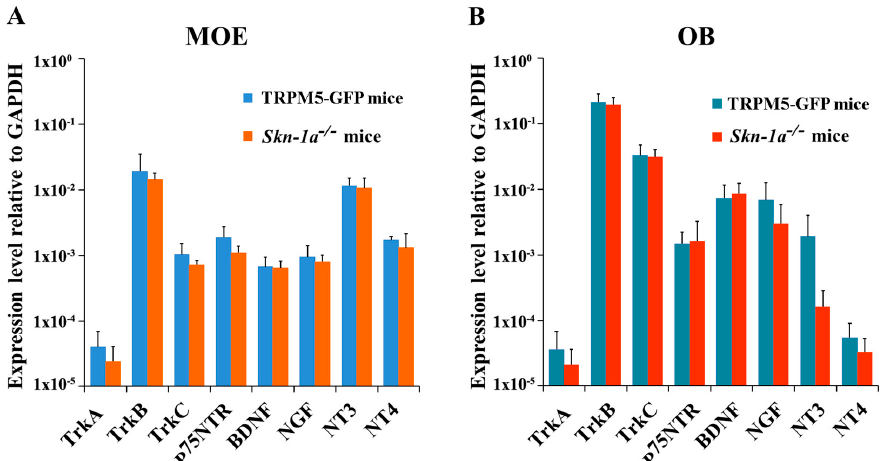
Figure 2. Expression levels of neurotrophin and neurotrophin gene transcripts in the MOE and OB of vehicle-exposed TRPM5-GFP and Skn-1a − / − mice. Real-time qPCR was performed using total RNA extracted from ( A ) olfactory turbinate tissue consisting primarily of the MOE, and ( B ) the OB. The expression levels are plotted relative to the expression of the Gapdh reference gene. ( A ) Expression levels of each NT and NTR in the MOE of TRPM5-GFP and Skn-1a − / − mice. Similar expression patterns across the NTs and NTRs were found in both TRPM5-GFP and Skn-1a − / − mice with NT-3 and TrkB expression levels being the highest among NTs and NTRs, respectively. No statistically significant differences were detected in the expression of each gene in the MOE between TRPM5-GFP and Skn-1a − / − mice (two-tailed independent t -test, p > 0.05, n = 6 mice). ( B ) Expression levels of NTs and NTRs in the OB of TRPM5-GFP and Skn-1a − / − mice. Among the NTRs examined, TrkB showed the highest expression in both TRPM5-GFP and Skn-1a − / − mice (one-way ANOVA with Tukey’s post-hoc test, p < 0.05, n = 6). No statistically significant differences were detected in the expression of each gene in the OB between TRPM5-GFP and Skn-1a − / − mice (two-tailed independent t -test, p > 0.05, n = 6 mice). Bar graphs represent the mean ± standard deviation (SD).